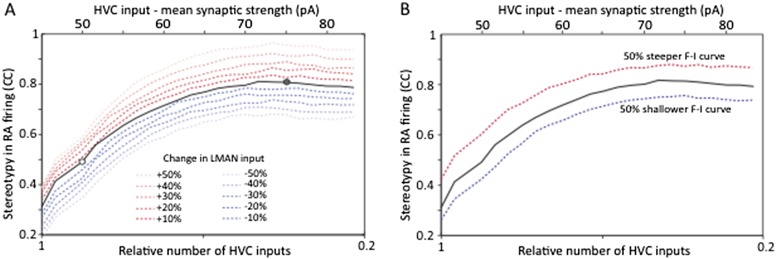
Strengthening and pruning of HVC‐RA synapses leads to reduced variability, and this trend is robust to changes in either LMAN input strength (A) or intrinsic properties or RA neurons (B). Both panels show average pair‐wise cross‐correlation (CC) between spike trains for different ‘song’ renditions in our model network. The x‐axis shows the mean synaptic strength of HVC input to RA (top) and the relative sparseness of HVC input to RA (bottom: 0 – all HVC neurons connect to the RA neurons, but weakly. 1 – a single, strong input from HVC). The model was parameterized to conform to the experimental data (white/grey circle denotes model parameters matching the observations in age groups 2 and 3, respectively). The strength of LMAN input was kept constant throughout. Tonic inhibition onto RA neurons was assumed proportional to the HVC drive. These parameters kept the firing rates of model RA neurons around 50 Hz, i.e. in their normal range during singing (Ölveczky et al., 2011). Note that the total drive from HVC to RA (which drives stereotyped firing) actually decreases as HVC inputs sparsen (LMAN, the variability inducing input stays the same). Thus, the reduced variability is due to a reorganization of HVC‐RA synapses, not a change in total input drive.